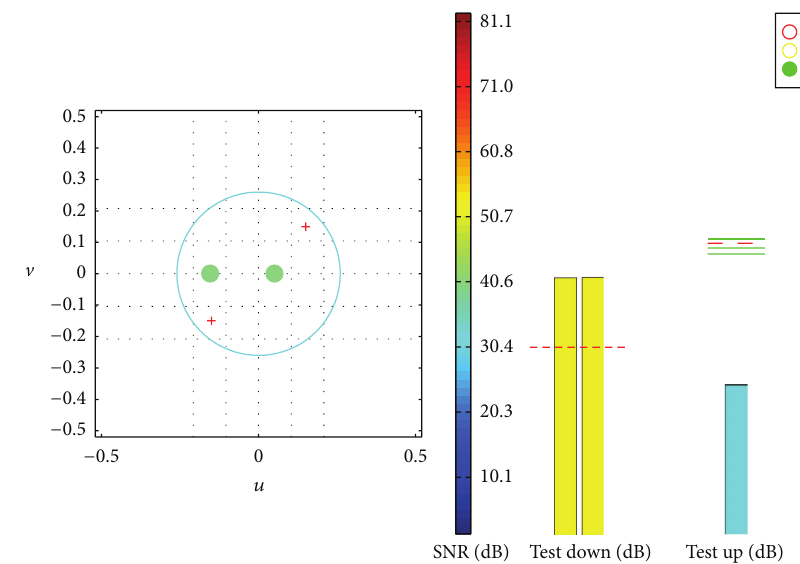
Figure 11: Combined target number and direction estimation for 2 targets with 7-element planar